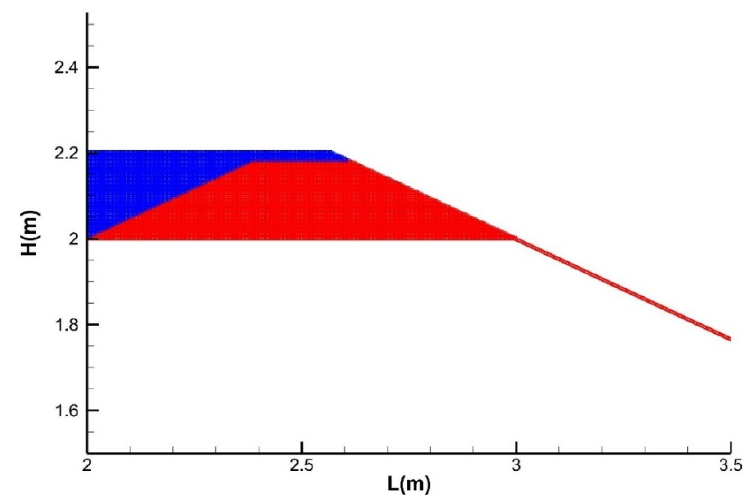
Figure 6. Initial state. The water level upstream maintained constant at h=0.2 m.